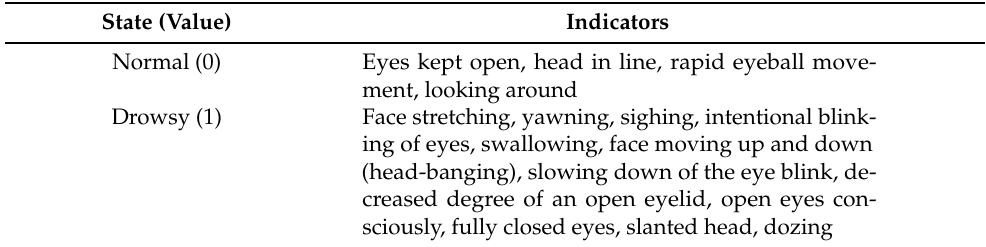
Table 3. Criteria for determining drowsy driving according to driver behavior. State (Value)